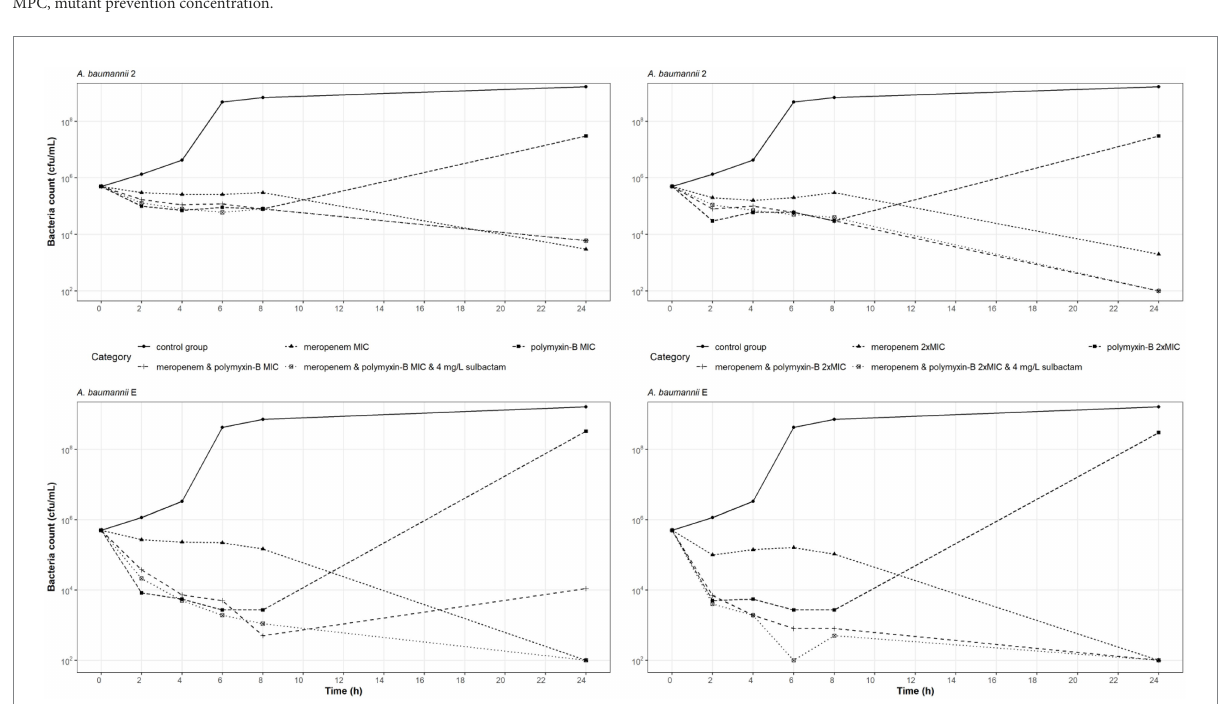
FIGURE 1 Static-concentration time-kill kinetics of meropenem and polymyxin-B alone and in combination at their respective MIC and 2 × MIC and also as triple combination with 4 mg/l sulbactam against two A. baumannii isolates. Monotherapy MICs for meropenem and polymyxin-B were 16 and 16 mg/l for isolate 2, and 128 and 16 mg/l for isolate E, respectively. MICs of meropenem and polymyxin-B were 4 and 4 mg/l for isolate 2, and 4 and < 1 mg/l for isolate E, respectively, in both the double and triple combinations.